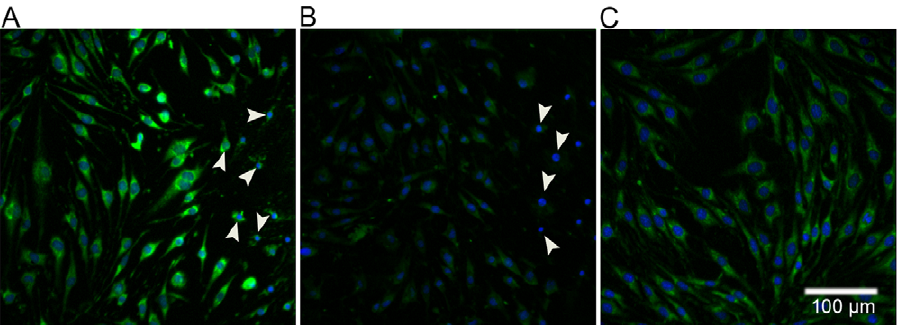
Figure 5. Peroxynitrite generation in bEnd.3 bystander cells following COI. A – Monolayers were subjected to COI, placed back in the incubator for three hours and then subjected to anti-nitrotyrosine antibodies first, and then to fluorescing secondary antibodies (pseudo-colored green). Arrowheads mark dead bystander cells (PI + ); blue depicts DAPI nuclear stain. B – Control, as in (A) but with secondary antibodies only, right side arrows mark dead bystander cells. C – Control, untreated monolayers subjected to primary and secondary antibodies. All images represent at least three similar experiments.